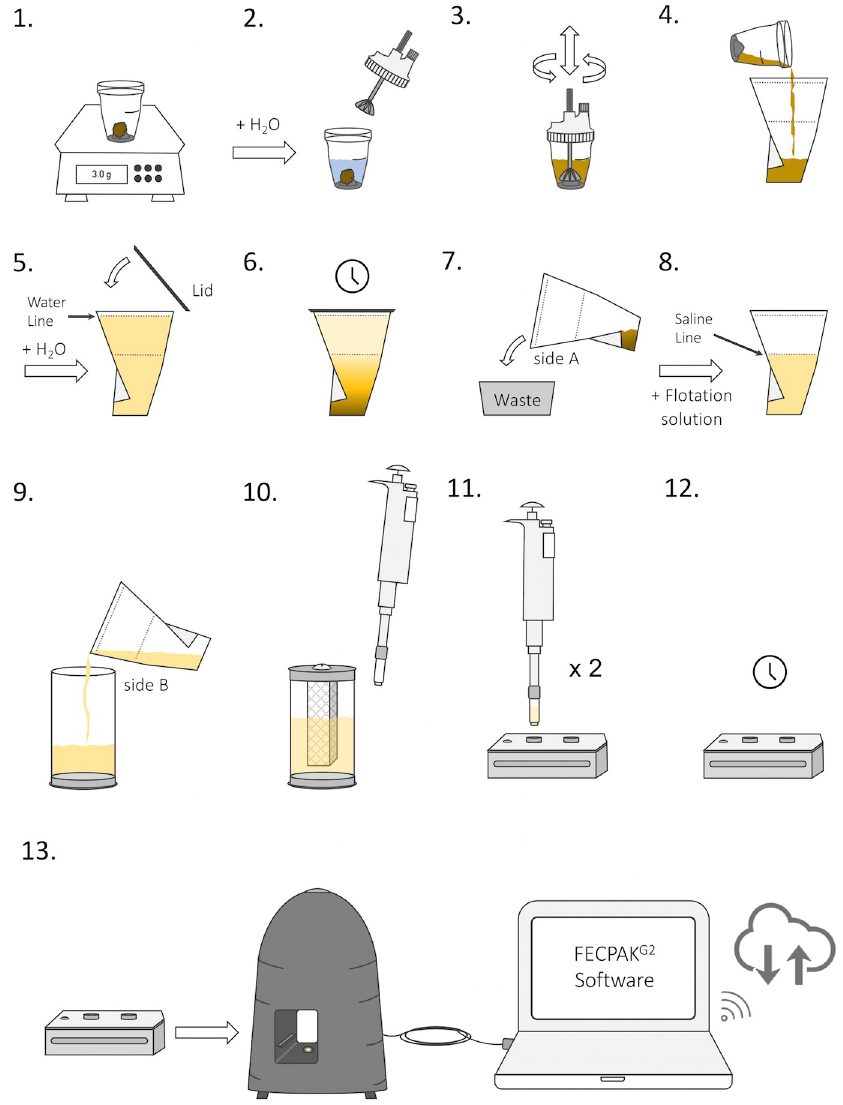
Fig 2. The FECPAK G2 standard operating protocol. Three grams of fresh human stool is weighed in a Fill-FLOTAC device (step 1), water is added and the stool is homogenized using the Fill-FLOTAC device (Step 2 & 3). The fecal suspension is then transferred to a FECPAK G2 sedimenter (step 4) and water is added to the water line (step 5 & 6). The supernatant is removed by tilting the sedimenter towards the A-side (step 7) and floatation solution is added to the retained slurry until the saline line is reached (step 8). This mixture is transferred into a FECPAK G2 filtration unit by pouring from the B-side of the sedimenter (step 9). The content is mixed by inverting the filtration unit 3 times and a sample is extracted from the inside of the inner sieve using a pipette with special tip. Samples are pipetted into both wells of a FECPAK G2 cassette (step 10 & 11). The filled cassette is then placed on a level surface to allow accumulation of the helminth eggs (step 12). Finally, the cassette is placed in the MICRO-I device and both wells are imaged (step 13). Images, together with accompanying sample information is stored and uploaded to the